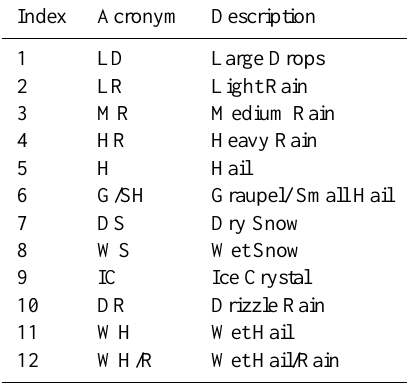
Table 2. Hydrometeor class indexes and corresponding microphys- ical description, used by the HYDRORAD classification